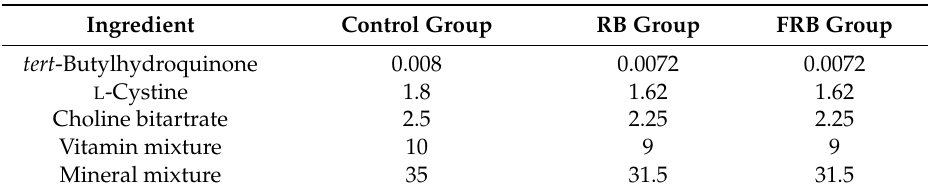
Table 1. Diet composition (g/1000